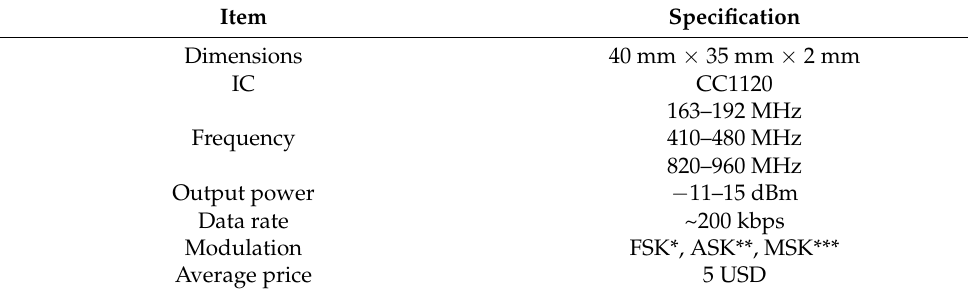
Table 1. Compact single-chip wireless module specifications.